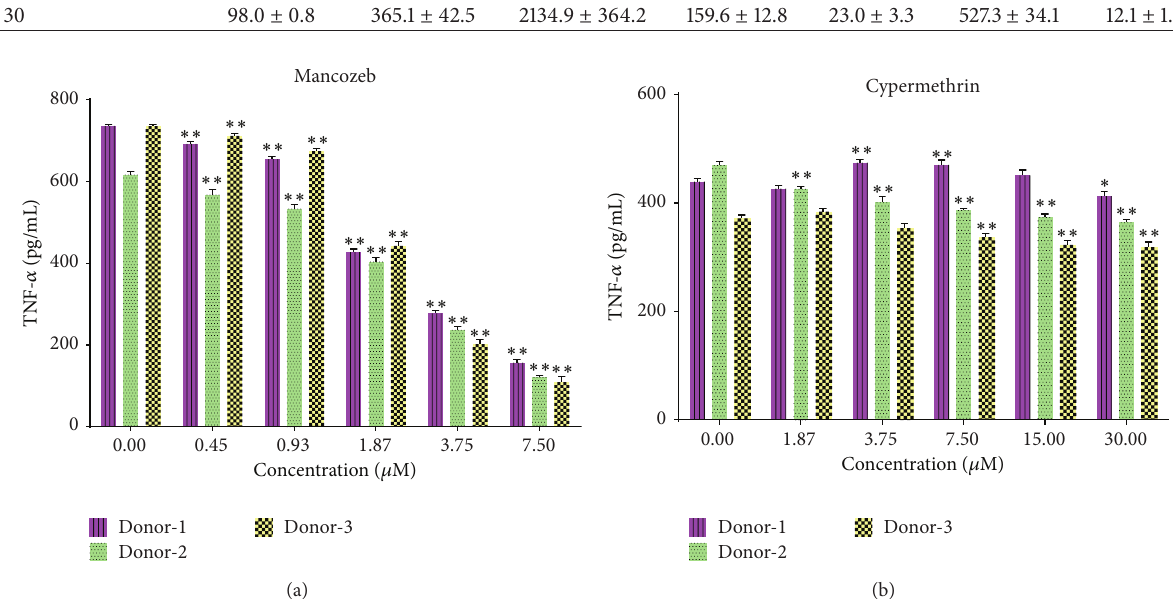
Figure 2: Proinflammatory response. Effects on levels of proinflammatory cytokine TNF 𝛼 in culture supernatants of PBMC. (a) Mancozeb. (b) Cypermethrin. Values shown are mean ( ± SE) from triplicate samples conducted with PBMC from three volunteers. ∗ 𝑃 < 0.05 ; ∗∗ 𝑃 < 0.01 versus zero control. For each donor, statistical analyses performed across the doses showed that values were consistently significantly different as a function of dose in the mancozeb